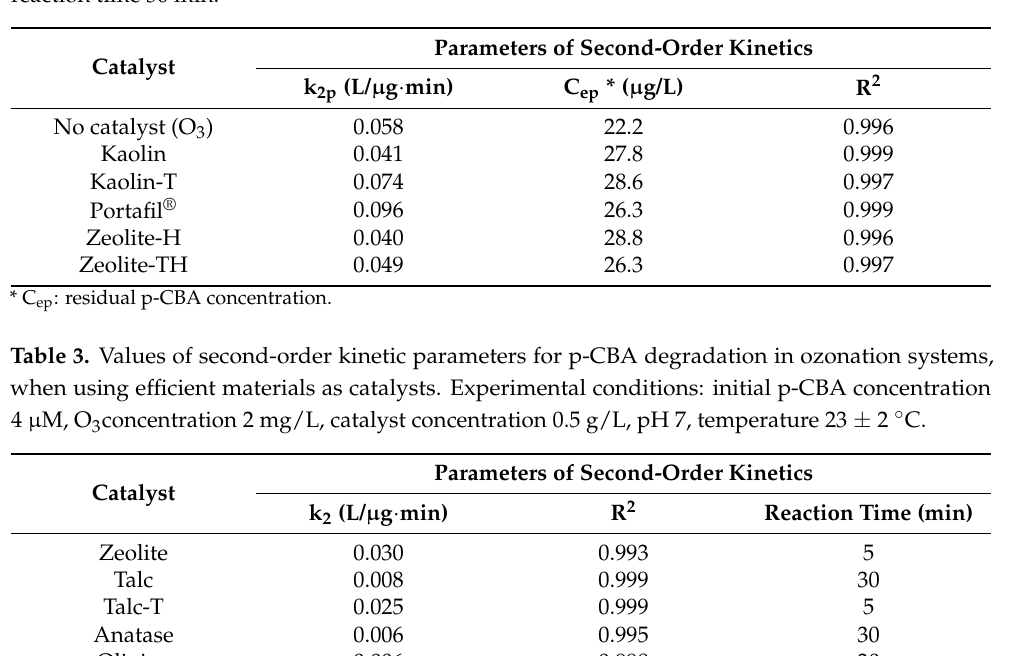
Table 2. Values of pseudo-second-order kinetic parameters for p-CBA degradation in ozonation systems, when using inefficient catalytic materials. Experimental conditions: initial p-CBA concentra- reaction time 30 min.